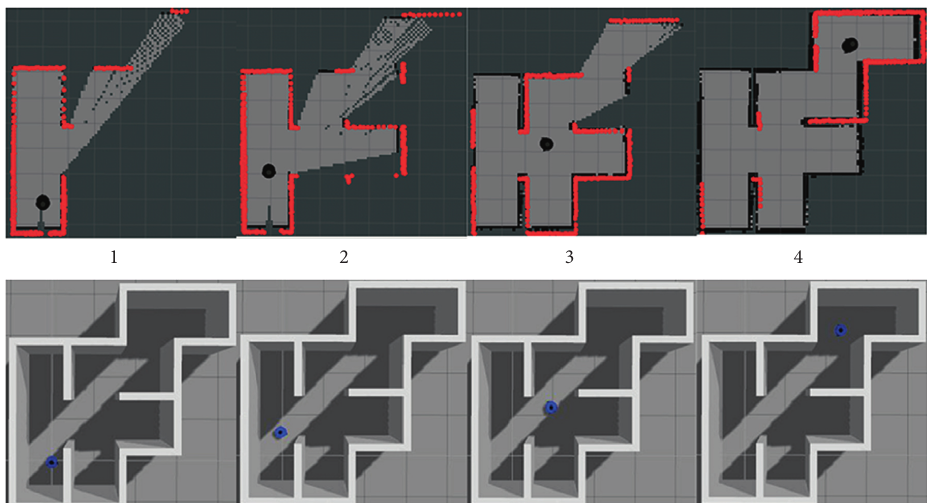
Figure 4: Mapping result of gmapping (simulation).